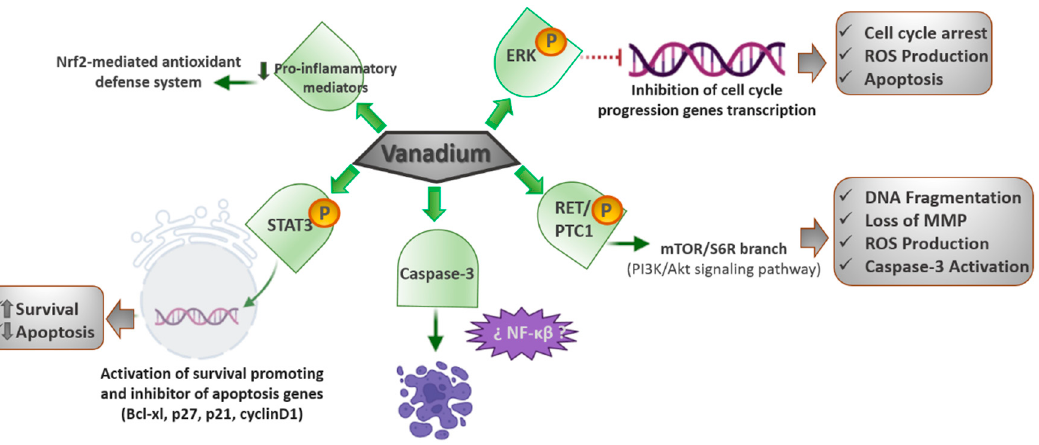
Figure 3. Upregulated proteins involved in survival and cell death induced by vanadium com ‐ plexes.